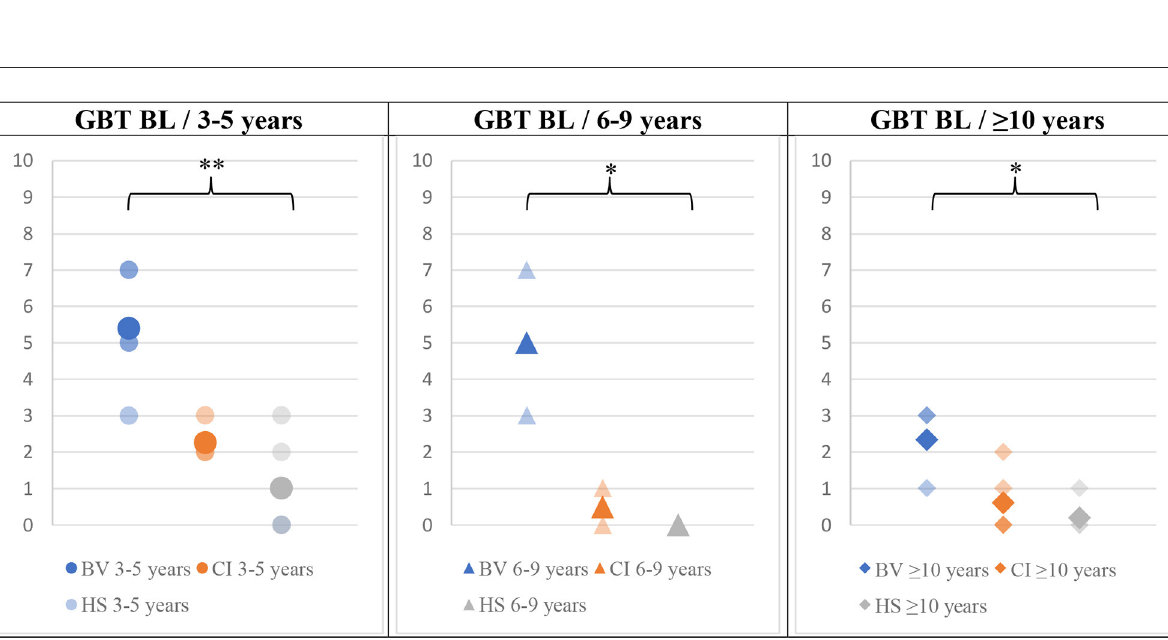
America) with a reference image showing the same mat with lines spaced 10 cm apart. Once the video and the reference image were superimposed, the transparency of the videos was adjusted to permit a better view of the lines and the subject. The alignment of the two videos could be controlled with the superposition of the two punctual night lights on both walls of the corridor. It was thus possible to measure the deviation to the midline during each walking trial frame by frame, for each subject (Figure 2). The scoring below was used to quantify the deviation in each